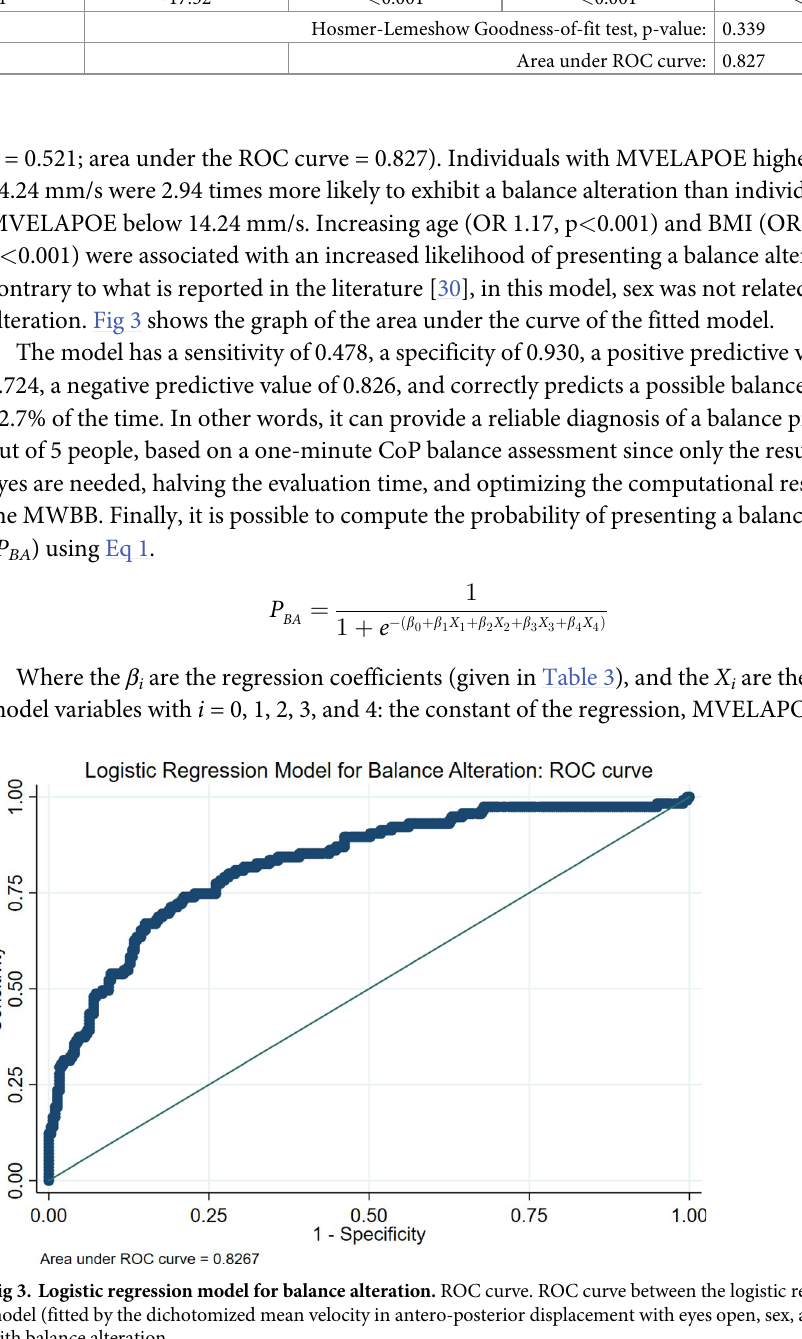
Fig 3. Logistic regression model for balance alteration. ROC curve. ROC curve between the logistic regression model (fitted by the dichotomized mean velocity in antero-posterior displacement with eyes open, sex, age, and BMI) with balance